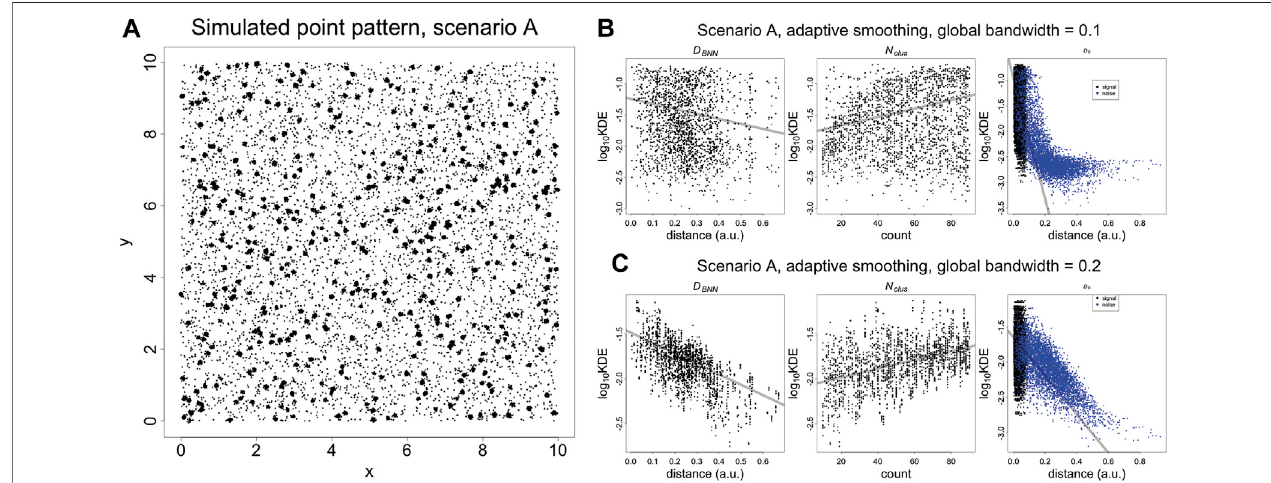
FIGURE 2 | (A) Simulated SMLM image of spatially random molecules. Molecules are generated using a Poisson process with intensity of fi ve over a square window with sides of length 10 (arbitrary units). The molecules are replaced with clusters of localisations, generated with a bivariate normal distribution with variance of 0.000625 and covariance of zero. The number of localisations per cluster is an integer randomly sampled on the interval (10, 90). Finally, the noise localisations are generated using a Poisson process with intensity of 50. D B , D BNN , N clus plotted vs Kernel Density Estimates (KDE). (B) KDE (adaptive smoothing) of Figure 4 fi tted withaglobalbandwidthof0.1. (C) KDE(adaptivesmoothing)of Figure4 fi ttedwithaglobalbandwidthof0.2.Atlowvaluesofthebandwidth,itispossibletodifferentiate betweensignalandnoiselocalisationsbutthetrendwith D BNN and N clus becomeslessclear.Atahighervalueofthebandwidth, thetrend D BNN and N clus becomesclear but it is no longer possible to differentiate between signal and noise localisations. This highlights that a KDE at using a single bandwidth is not adequate to capture the entire spatial structure. Trend lines are fi tted with a linear model and are supplied for visualisation